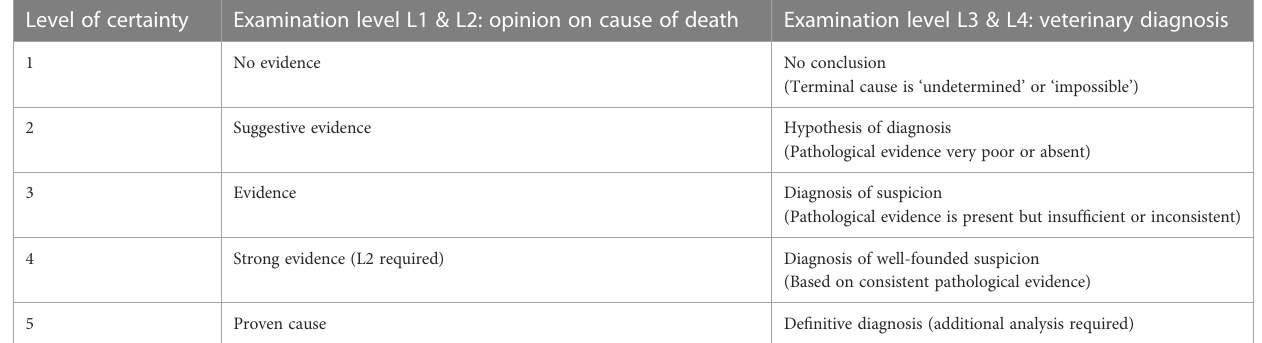
TABLE 4 De fi nitions of level of certainty according to the level of examination (L) performed. Level of